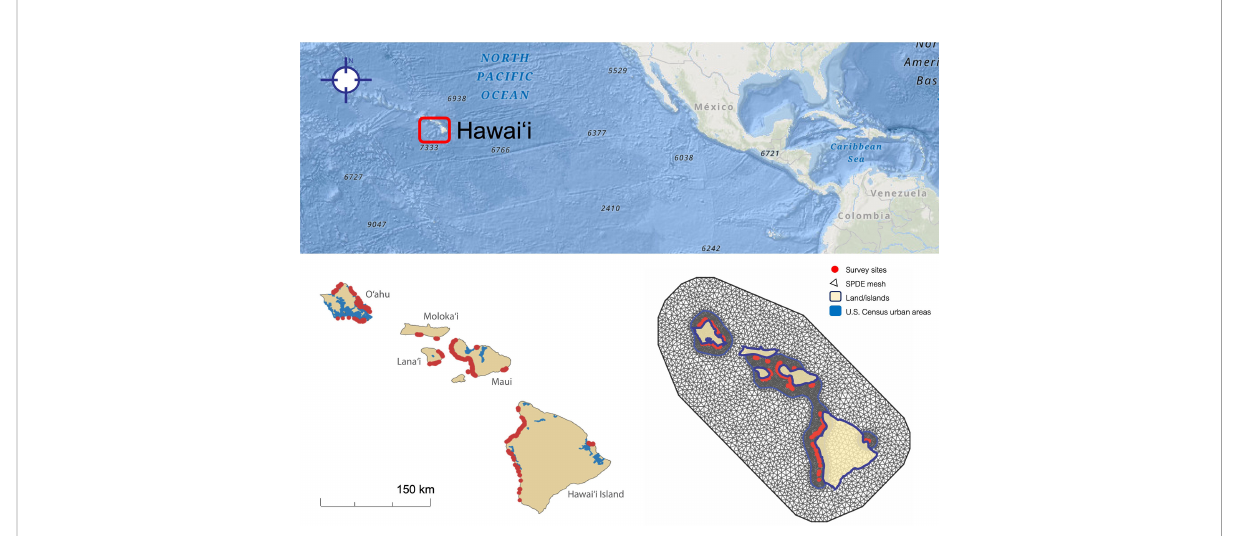
FIGURE 2 Coral bleaching site distribution (n = 1024) in fi ve Main Hawaiian Islands. (Left) Observation sites for coral bleaching surveys (red) shown alongside urban areas (blue). (Right) Spatial mesh for modeling site spatial structure and spatial